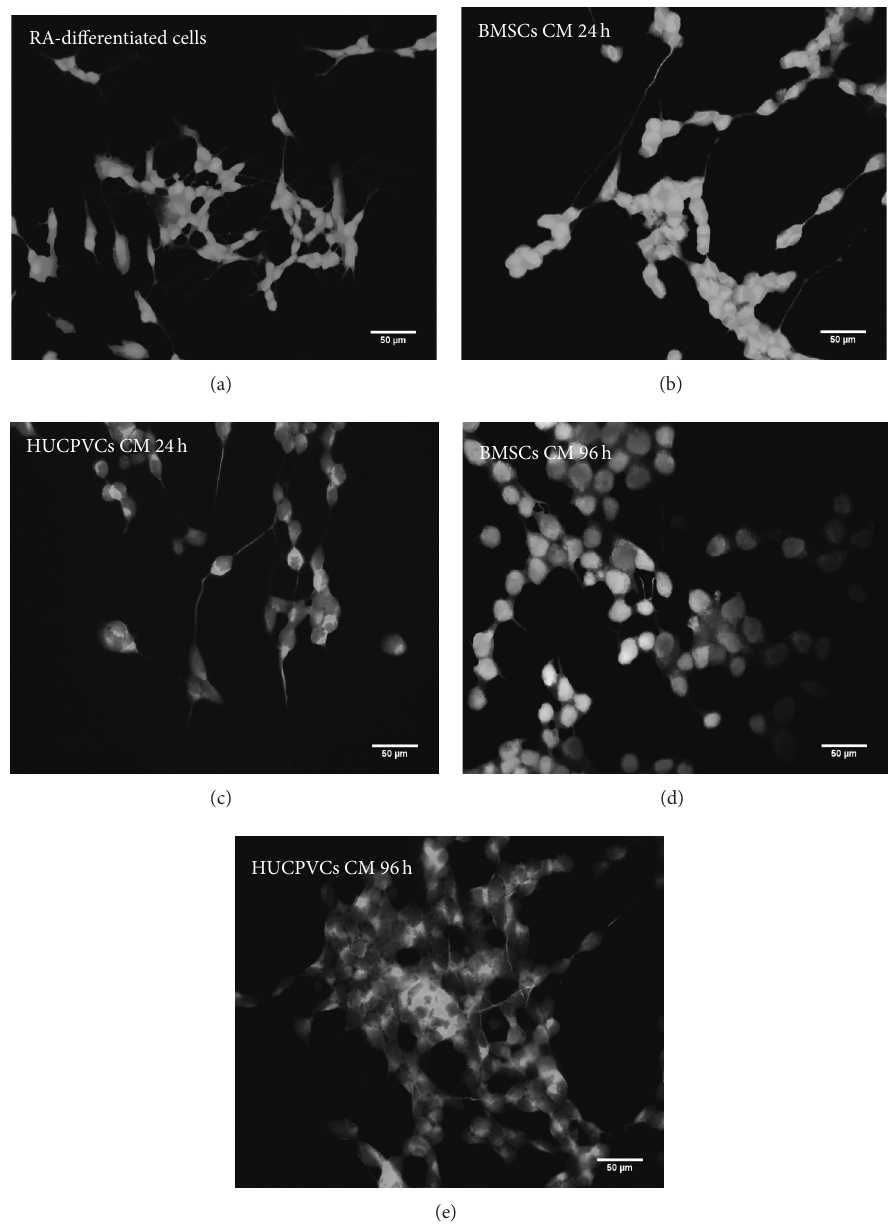
Figure 5: Representative micrographs (magnification: 40x) used to quantify neurite outgrowth in SH-SY5Y cells seven days after incubation with RA (a), BMSCs CM (24h, 96h: (b), (d)), and HUCPVCs CM (24 h, 96 h: (c), (e)) through the use of neurite tracer plugin from Image